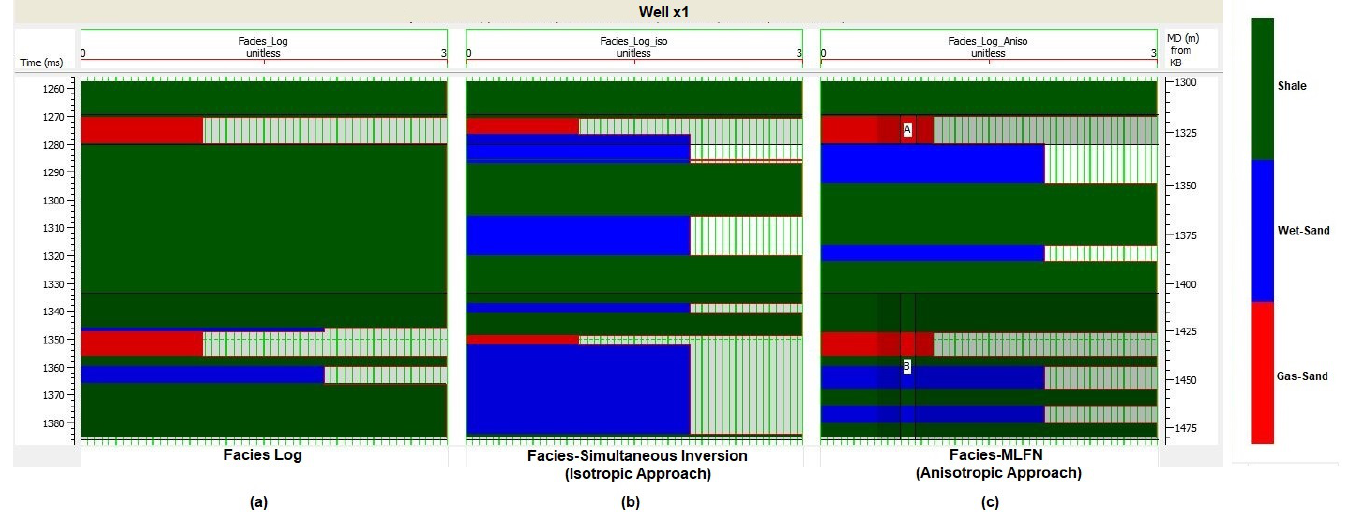
Figure 28. The litho-fluid facies at the well ( × 1): ( a ) log facies, ( b ) simultaneous inversion facies, and ( c ) MLFN facies. Table 3. The correct classification rates of the litho-fluid classes for isotropic inversion and MLFN. Method Gas Sand Wet Sand Shale All Facies Isotropic